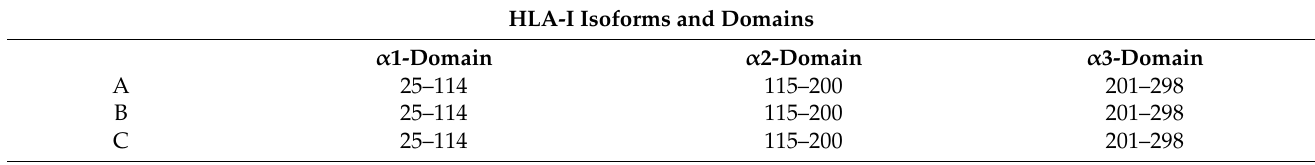
Table 2. HLA Class I and II isoforms and the shared sequences in the α 3-domain in HLA-I and β 2 domain HLA-II that bind to T cell